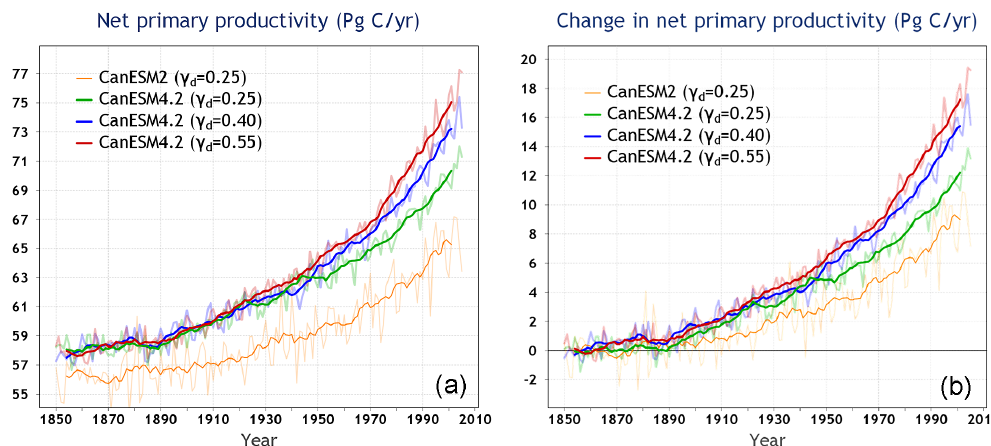
Figure 6. Absolute values of (a) and change in (b) net primary productivity (NPP) from CanESM2 and the three CanESM4.2 historical 1850–2005 simulations with different strengths of the terrestrial CO 2 fertilization effect. The thin lines show the ensemble-mean based on results from the two ensemble members and the bold lines are their 10-year moving averages.